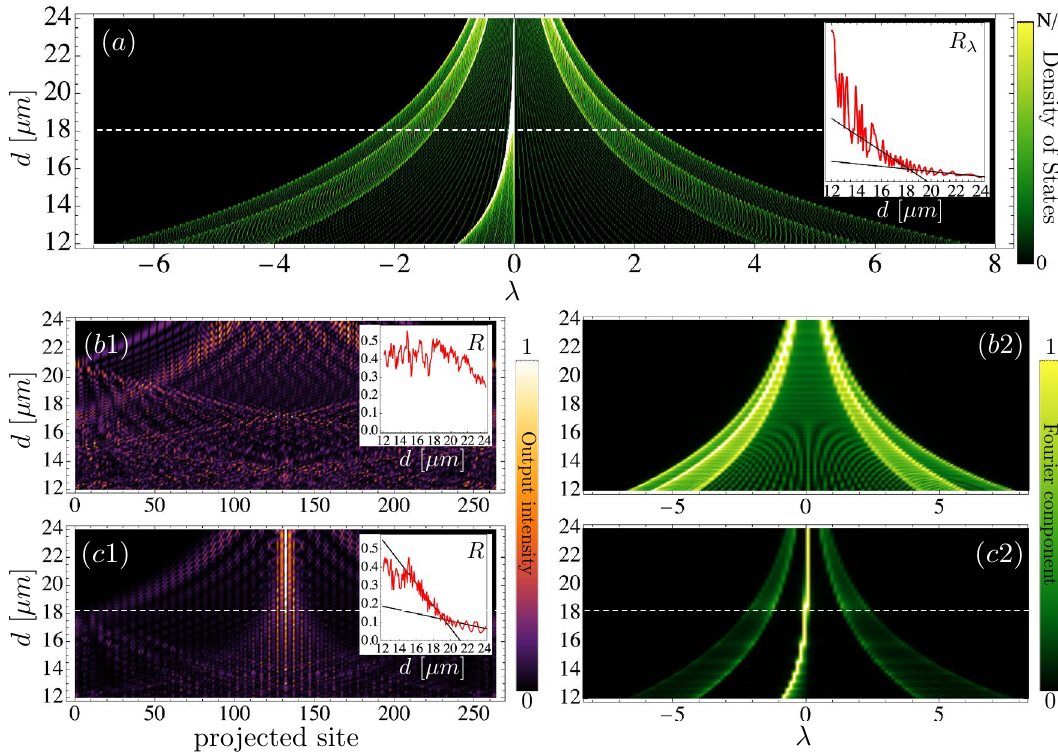
Figure 3. ( a ) Linear spectrum and density of states versus nominal distance d . Inset: dependence of the participation ratio in frequency space R (cid:31) versus distance d . ( b ) and ( c ) excitation of bulk- A and bulk- B sites, 2 respectively. ( b1 ) and ( c1 ) intensity output profiles | u � n ( z max ) | , for z max = 100 , versus distance d where, for simplicity, the lattice is projected on a 1D row. Insets: participation ratio R for output intensities versus distance d . ( b2 ) and ( c2 ) dynamically excited frequency spectrum versus distance d . This figure was drawn using Wolfram Mathematica 12 and Omnigraffle